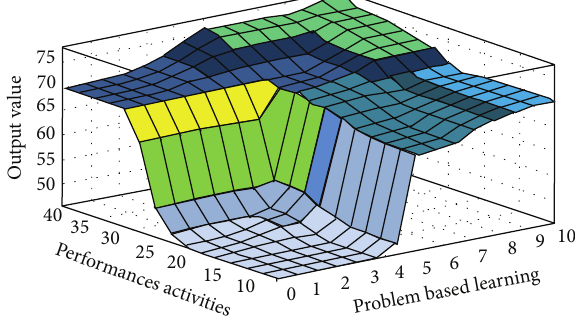
Figure 3: Input and output 3D mapping (performances activities and energy-saving public Facility).